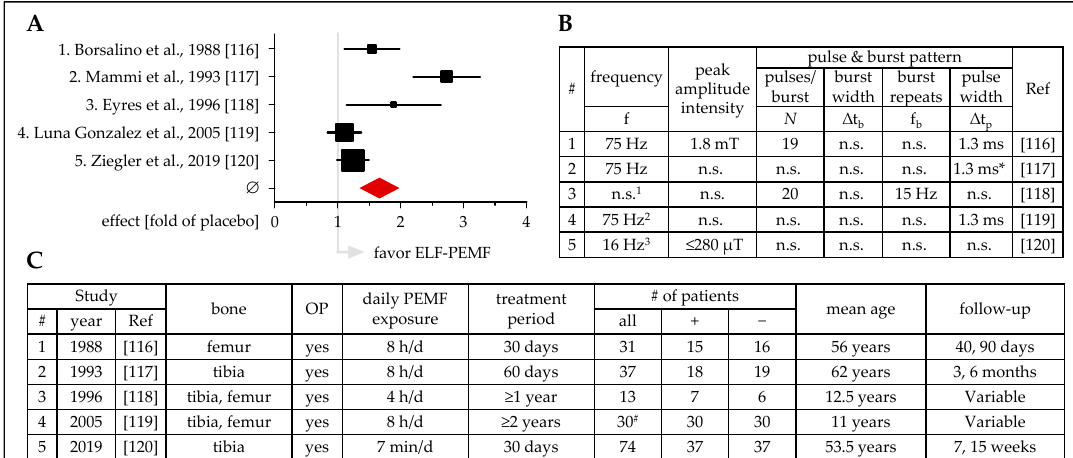
Figure 5. Clinical studies (prospective, placebo-controlled, blinded) investigating the effect of ELF-PEMF treatment on osteotomies. ( A ) Forest plot showing ELF-PEMF effects fold of placebo ± 95% C.I.—sum was calculated as described by Neyeloff et al. [107], with weighting based on sample size. ( B ) Overview on the ELF-PEMFs used in the presented studies. ( C ) Overview on the presented studies including affected bones, number of patients, treatment, and follow up. 1 device from Electro-Biology Inc, Fairfield, NJ, USA; 2 BIOSTIM ® , IGEA S.p.A., Carpi, Italy; 3 Somagen ® , Sachtleben GmbH, Hamburg, Germany; f: frequency; ∆ t b : burst width; f b : burst repeats; ∆ t p : pulse width; # left-right comparison; OP: surgery; + ELF-PEMF treatment; − placebo treatment; n.s.: not specified; * obtained from secondary source.